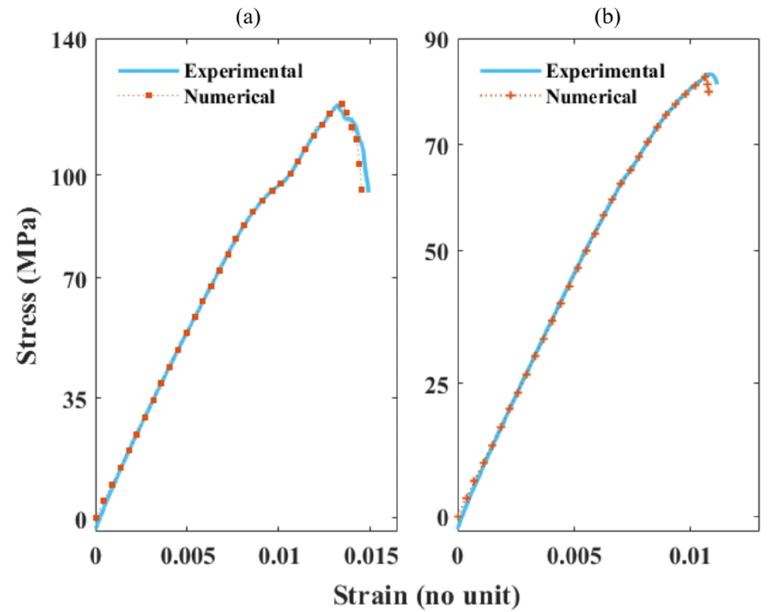
Figure 9. Comparing the experimental and numerical SS curves of rGF/EP composites: ( a ) SS curves of 60% rGF/EP; ( b ) SS curves of 40% rGF/EP.